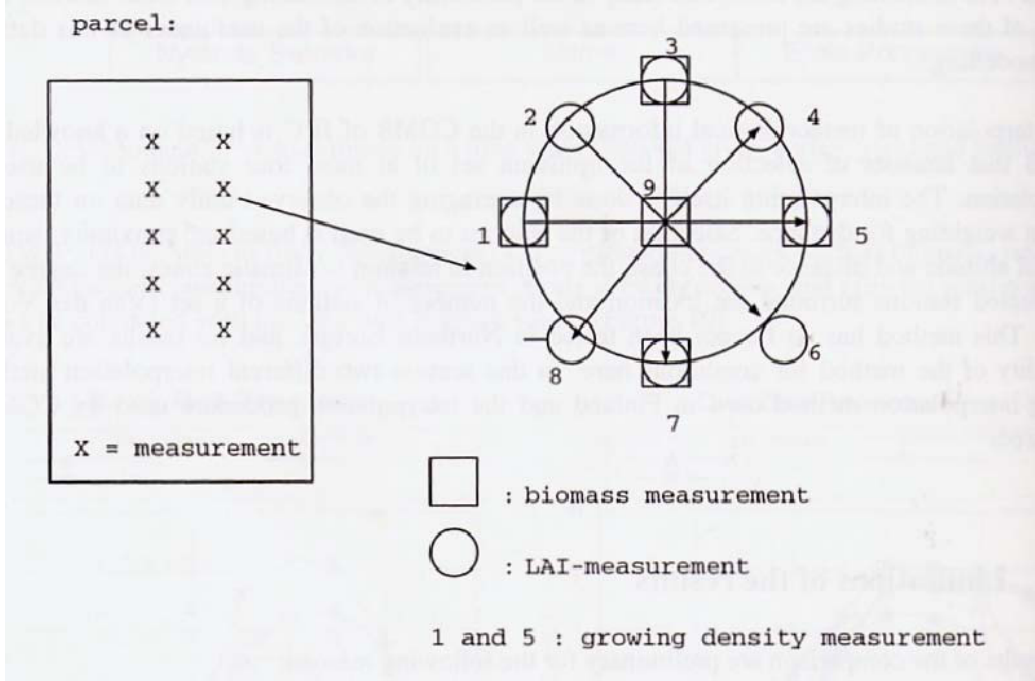
Figure 6. Ground truth sampling methodology and LAI measurements with portable Li-Cor 2000 Plant Canopy Analyzer